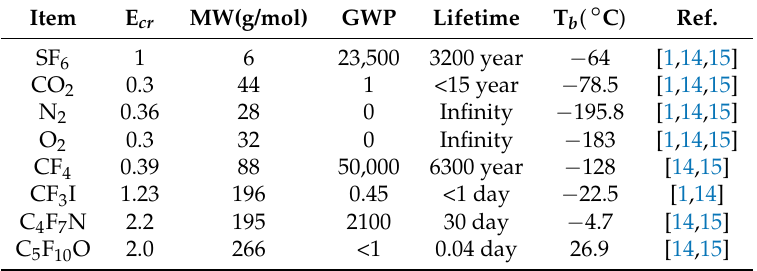
Table 1. Properties of different